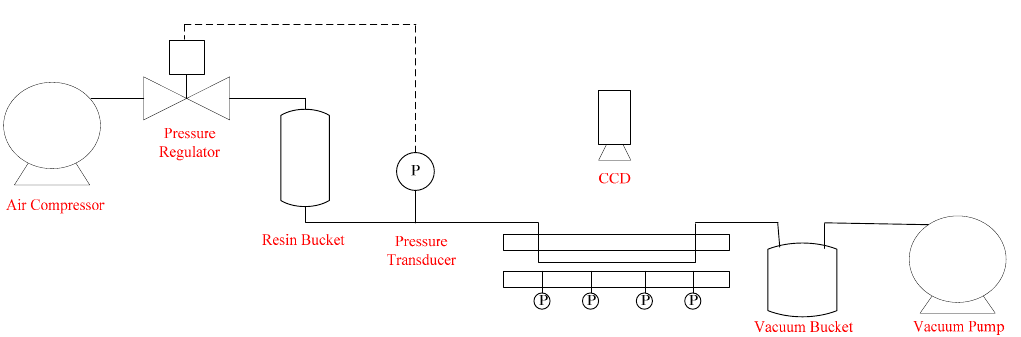
Figure 1. Piping and instrumentation diagram (P&ID) chart of experimental setup.